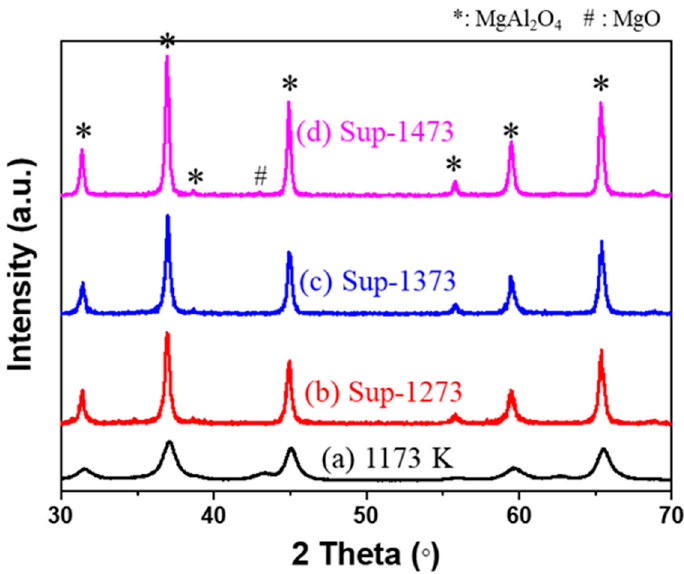
Figure 2. XRD patterns of MgAl 2 O 4 pellets after the second calcination and MG30 powder after calcination at 1173 K.